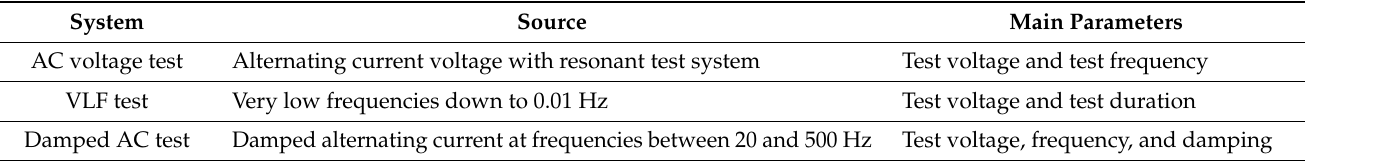
Table 2. Different off-line PD